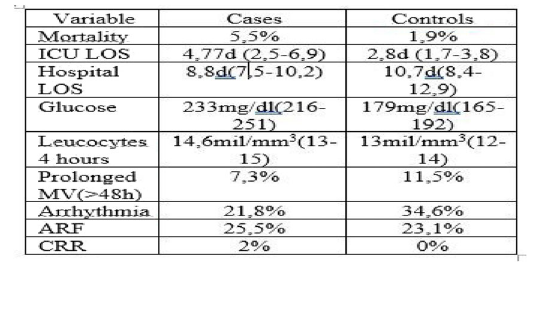
Table 3 (abstract 00627). See text for description